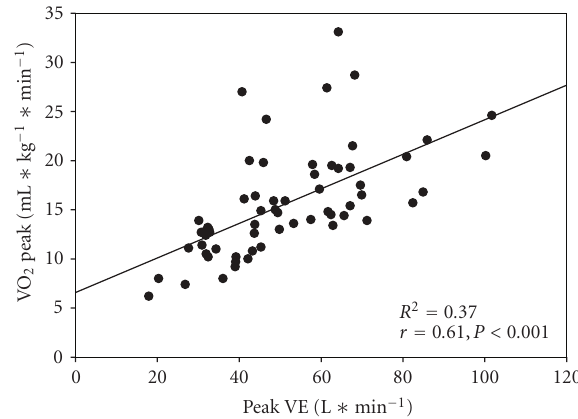
Figure 1: Scatterplot with a regression line overlay to demonstrate the relationship between VO 2 peak and peak minute ventilation (VE).